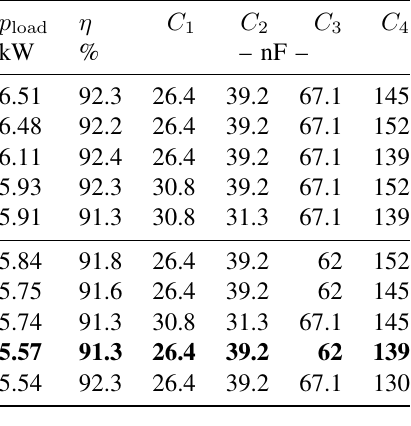
TABLE V T IME AVERAGED MAXIMUM POWER TRANSFER AND EFFICIENCY FOR THE TOP TEN CAPACITANCE COMBINATIONS OF THE CAPACITOR